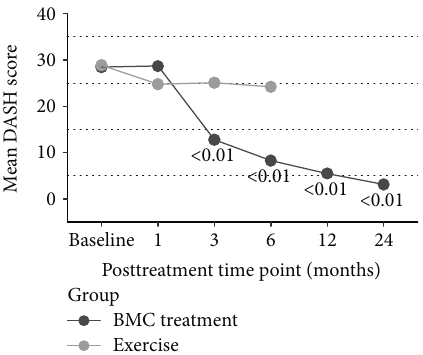
Figure 2: DASH scores at baseline and follow-up time points . Displayed p values re fl ect comparison to baseline. Exercise N : 9, 10, 5; treatment N : 23, 22, 24, 24, 23, 17.